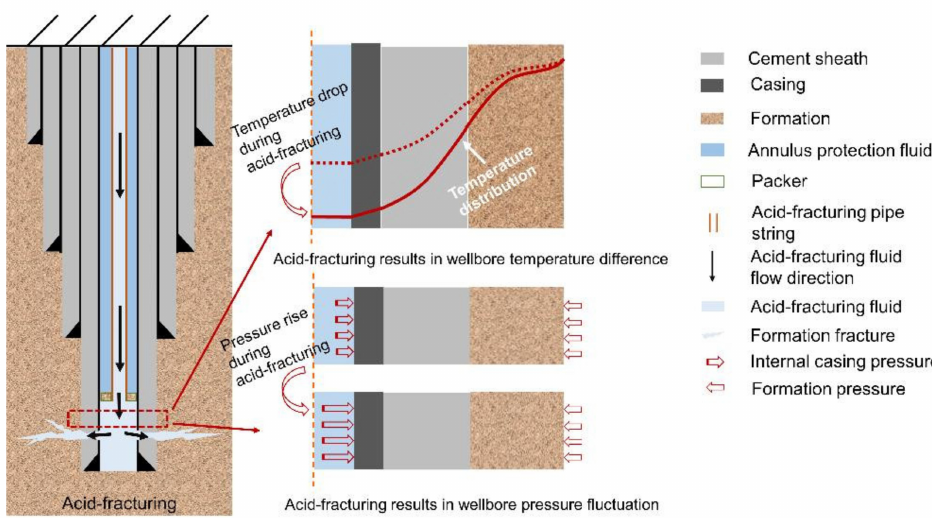
Figure 1. Schematic diagram of acid-fracturing and the change rule of the temperature and pressure during